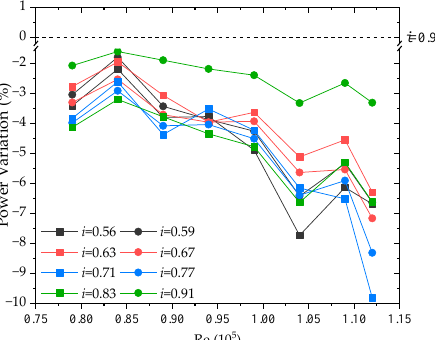
Figure 6. Power Variation in hover (compared with i = 0.98).